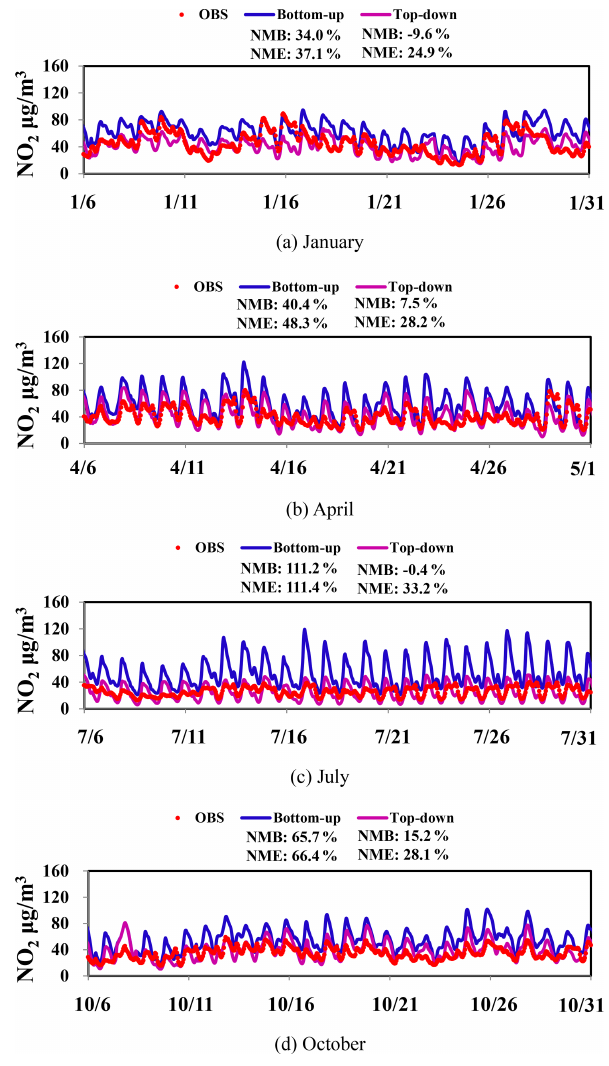
Figure 4. The observed and simulated hourly NO 2 concentrations based on the bottom-up and top-down NO x emissions for January, April, July, and October